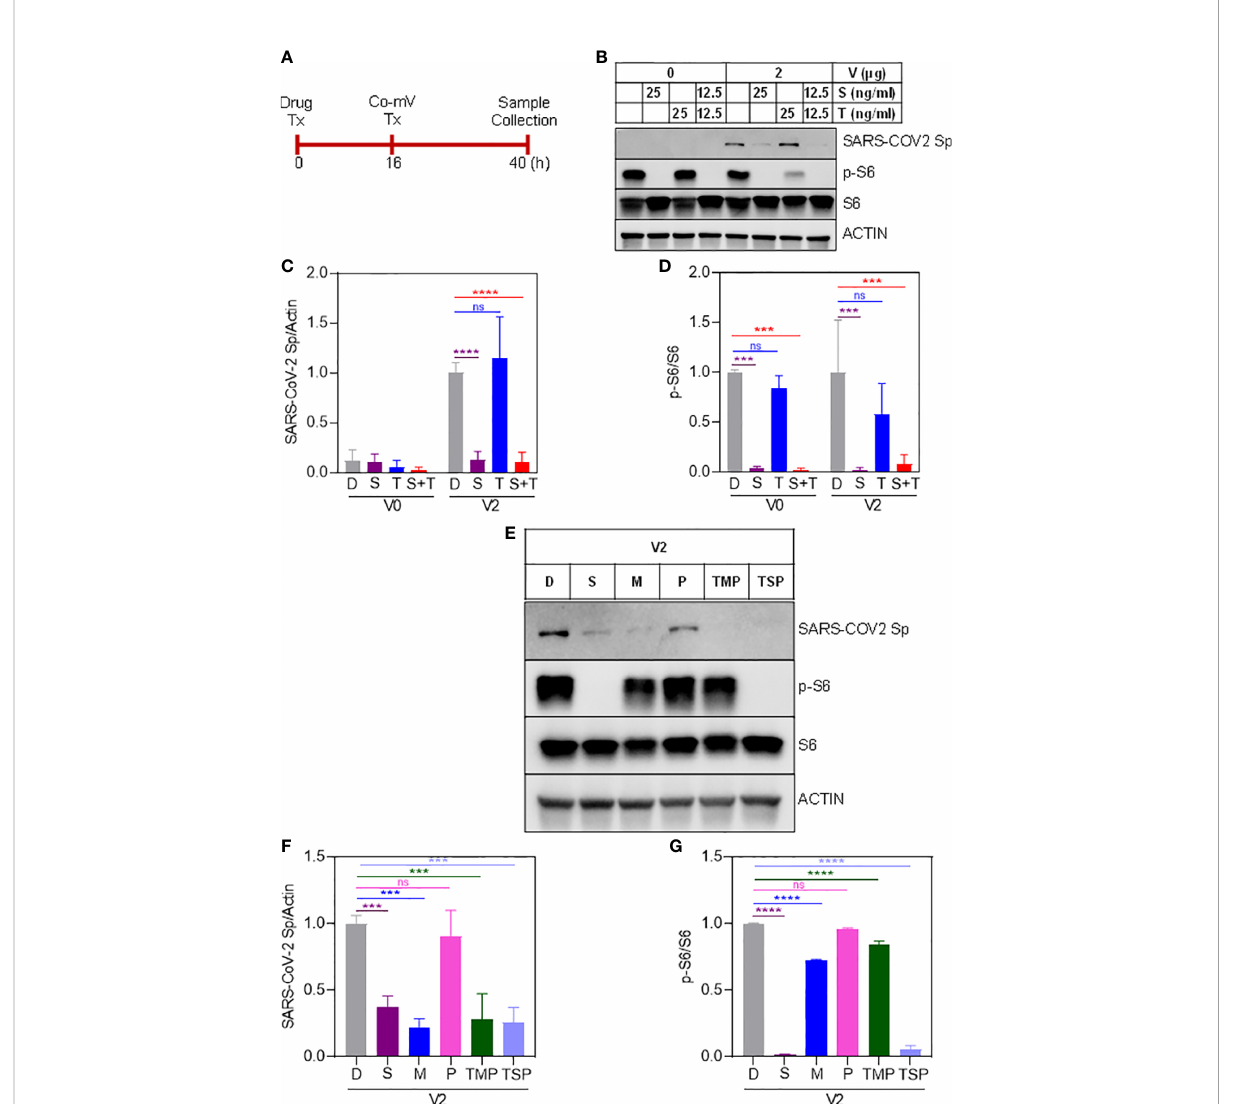
FIGURE 3 Sirolimus and mycophenolate reduces P fi zer Co-mV-induced expression of Sp protein and phosphorylation of pS6 in HEK293 cells. (A) Drug and 2 m g P fi zer BioNTech Co-mV treatment schedule in HEK293 cells. (B) Western blot for SARS-CoV-2 Sp protein expression in HEK293 cells pre-treated over 16 h with 25 ng/mL each individually with sirolimus and tacrolimus (FK506), or their combination at 12.5 ng/mL each and with an additional 24 h treatment along with 2 m g P fi zer BioNTech Co-mV [as described in panel (A) ]. DMSO treatment served as controls. The same blots were stripped and reprobed with pS6, S6, and b -actin antibodies. (C) Expression of SARS-CoV-2 Sp protein normalized to actin and (D) phospho-speci fi c protein S6 to total S6 in the immunoblots illustrated in panel (B) were quantitated by densitometry and the relative levels to DMSO controls were represented. (E) HEK293 cells were pre-treatment for 16 h with the indicated drugs either alone or in a combination of TSP or TMP at the concentrations (described in materials and methods) and with an additional 24 h treatment along with 2 m g P fi zer BioNTech Co-mV. At the end of the experimental period, equal amount of protein lysates from all the groups were analyzed using Western blotting for protein expression of SARS-CoV-2 Sp, phospho-speci fi c pS6, total S6, and actin as a loading control. (F, G) Quanti fi cation of the immunoblots in panel (E) expressed as a ratio of SARS-CoV-2 Sp to Actin; and phospho-speci fi c protein S6 to total S6, respectively. Relative values to DMSO controls were shown. Data was expressed as the mean ± SD (n=3). For panels (C, D) that involves 2 different doses, the statistical inferences between DMSO and treatment groups were made from a two-way ANOVA, Tukey post-hoc multiple comparisons and for panels (In panel (C) , **** p < 0.0001; In panel (D) , *** p = 0.0004 [V0 – D vs S]; *** p = 0.0003 [V0 - D vs S+T]; *** p = 0.0003 [V2 – D vs S]; *** p = 0.0006 [V2 – D vs S+T]). For panels (F, G) that involves a single dose, the statistical inferences were made from a one-way ANOVA with Tukey post hoc multiple comparisons test (In panel (F) , *** p = 0.0008 [D vs S]; *** p = 0.0001 [D vs M]; *** p = 0.0002 [D vs TMP & D vs TSP]; ns – not signi fi cant; In panel (G) , p = **** p < 0.0001, ns – not signi fi cant). Co-mV, COVID-19 mRNA vaccine; Tx, treatment; V0, no CO-mV; V2, 2 m g Co-mV; D or C, dimethyl sulfoxide (DMSO); S, sirolimus; T, tacrolimus; P, prednisone; SARS-CoV-2 Sp, severe acute respiratory syndrome coronavirus 2 spike; S6, S6 ribosomal protein; pS6, phospho-S6 ribosomal